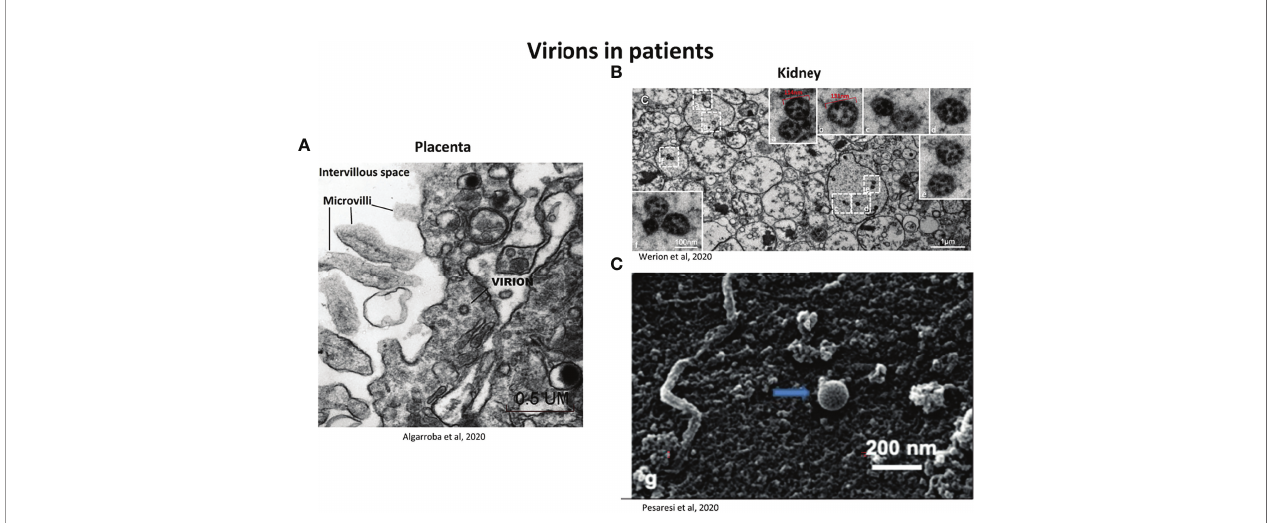
FIGURE 4 | Representative electron micrographs showing the localization of SARS-CoV-2 virions in patients (A) Virion invading a syncytiotrophoblast (placenta) observed by TEM (50 000X). Scale bar: 0.5 µm (Algarroba et al., 2020). (B) Viral particles inside vacuoles inside the smooth endoplasmic reticulum (kidney section). Low magni fi cation for the dashed-line boxes (scale bar: 1 µm) and high magni fi cation for the solid line boxes (scale bar: 100nm) corresponding to the dashed-line boxes (a-f). Particles have irregular dense black dots inside and some (e.g. b and e) have crisp small rings (Werion et al., 2020). (C) SARS-CoV-2 located on the surface of a membrane of renal tissue, observed by SEM. Scale bar: 200 nm (Pesaresi et al.,